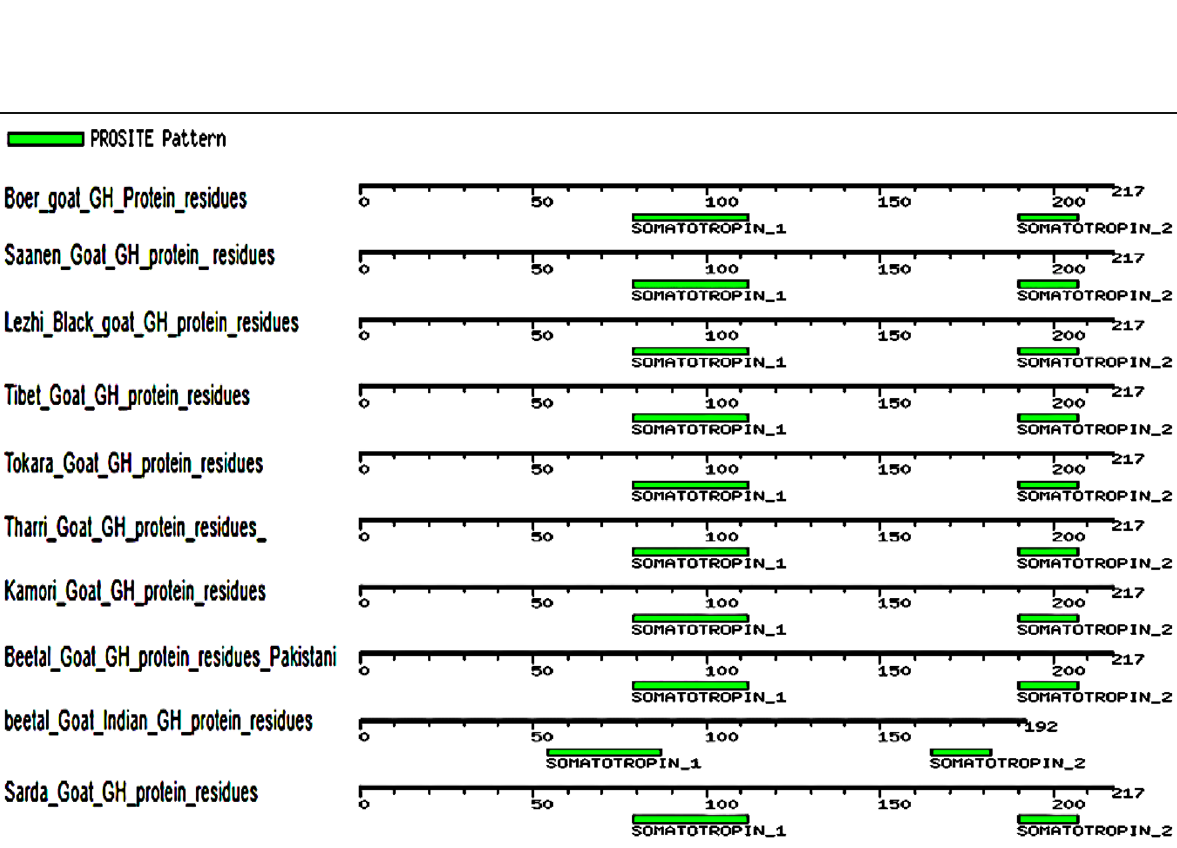
Fig. 15 Motif patterns of Bo_GH protein sequence compared with GenBank